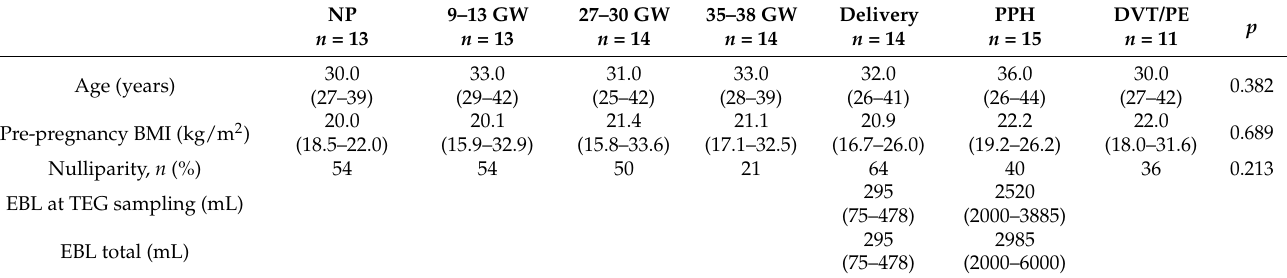
Table 1. Characteristics of the study population.